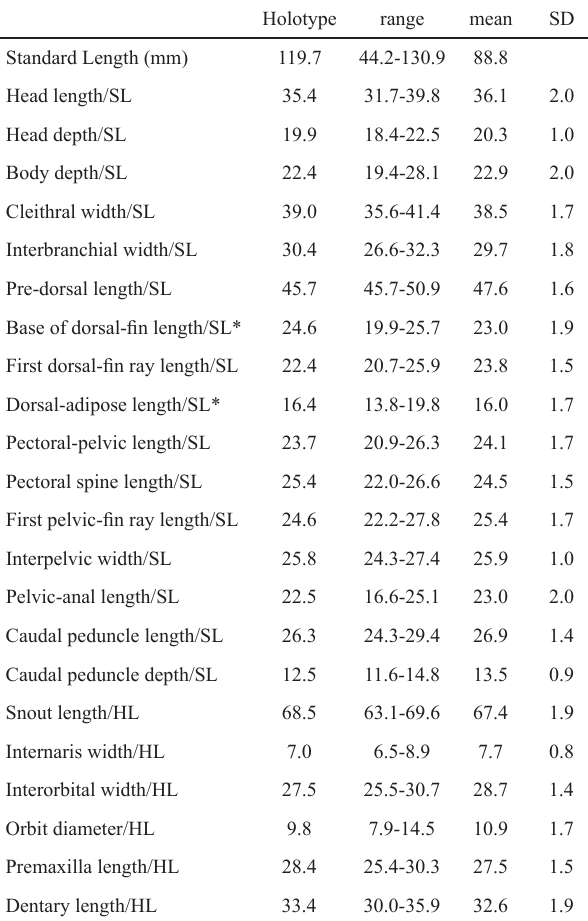
Table 1. Proportional measurements of Chaetostoma spondylus , expressed as percents. Range, mean, and